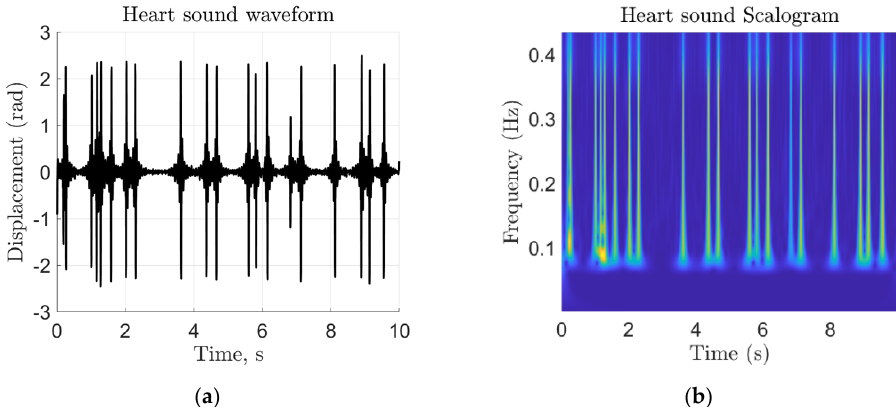
Figure 3. Heart sound signal representations as ( a ) a time-domain chest displacement waveform and ( b ) a time-frequency representation based on the absolute value of the CWT coefficients of ( a ), which is the final output corresponding to each scan.